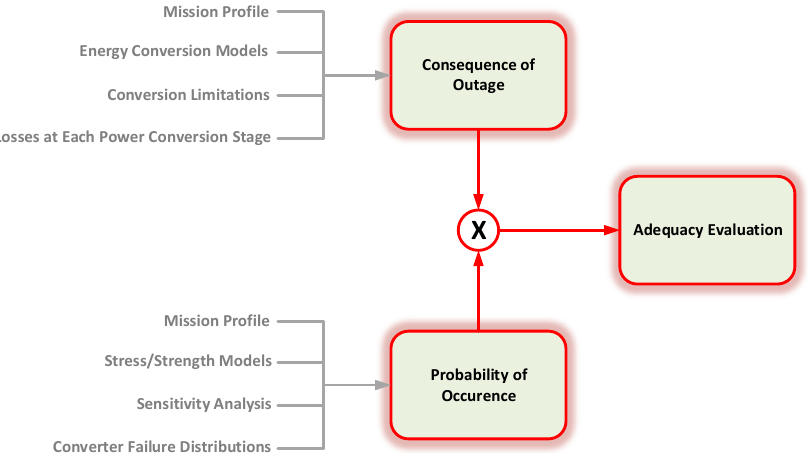
Figure 1. Flowchart outlining the concepts needed to be considered when evaluating the sys- tem